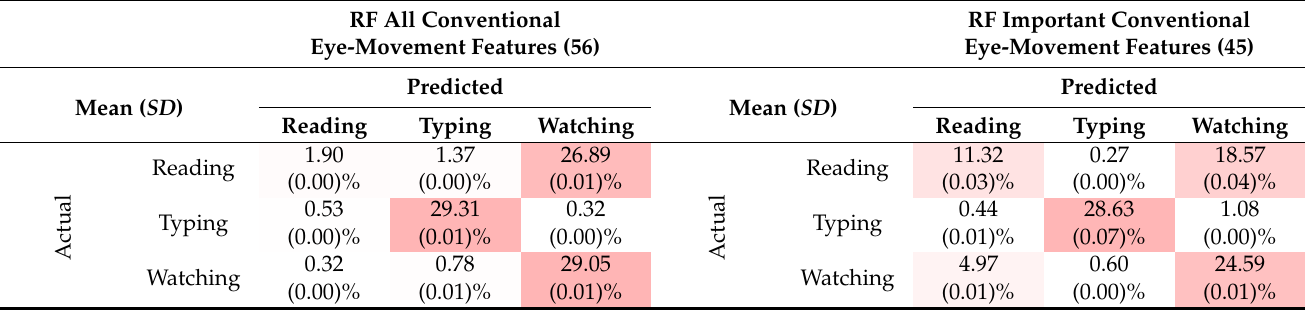
Figure 3. Accuracy comparison of 6 types of ML models built using conventional eye-movement features. The number of used features for building the models is indicated by numbers in parentheses. Means that do not share a letter are significantly different. Table 4. Confusion matrices of the RF Models built both using all and important conventional eye-movement features.